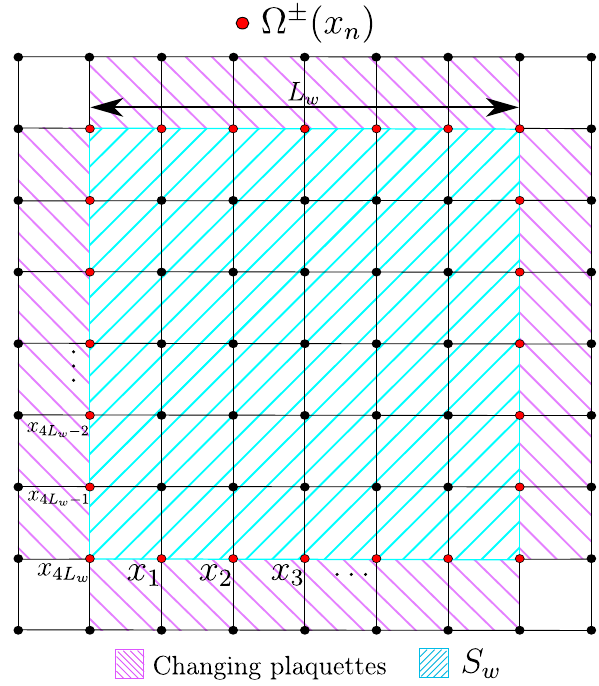
Fig. 2 Sketch of a winding transformation of size L w . Gauge links whose starting and ending points are both in the blue region transform according to Eq. (19), while the others stay the same. Only the 1 × 1 Wilson loops in the violet region change